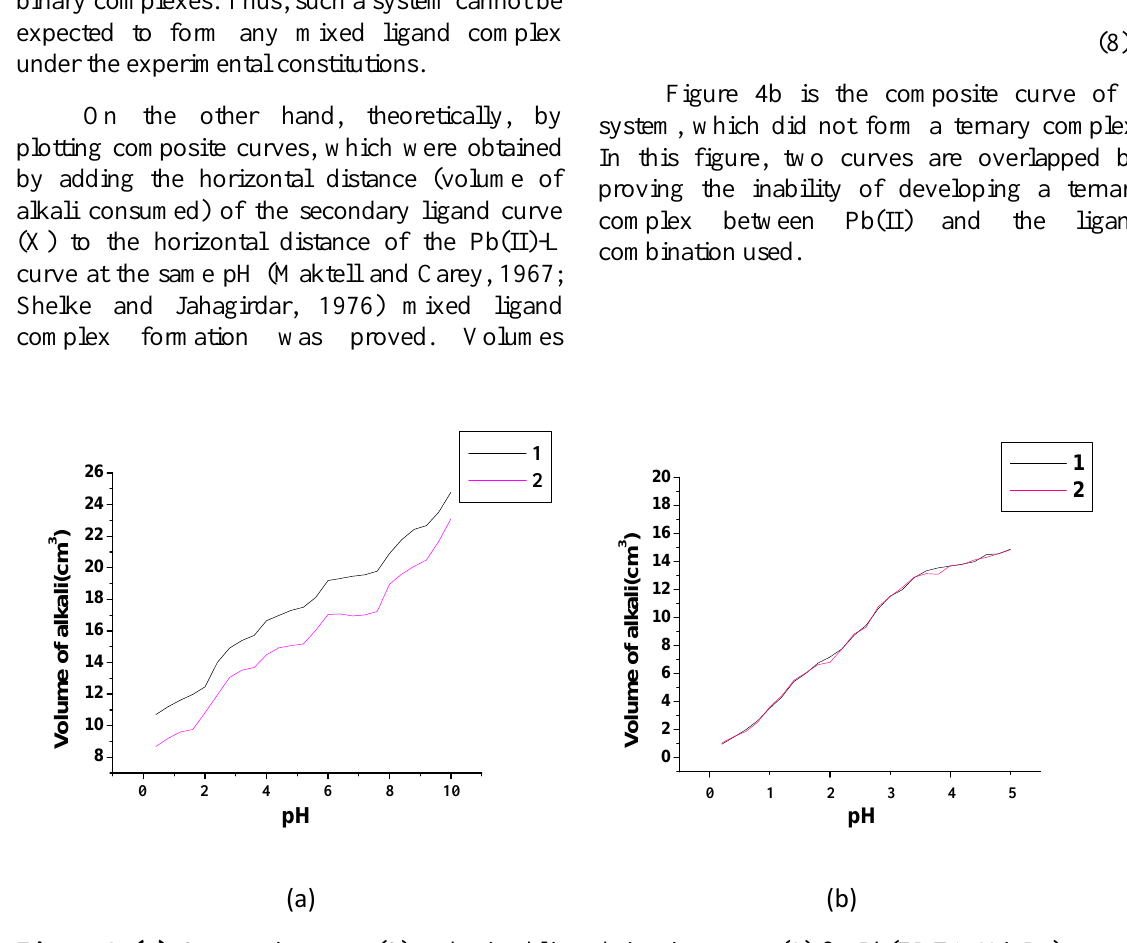
) ternary 1 ) ternary 3